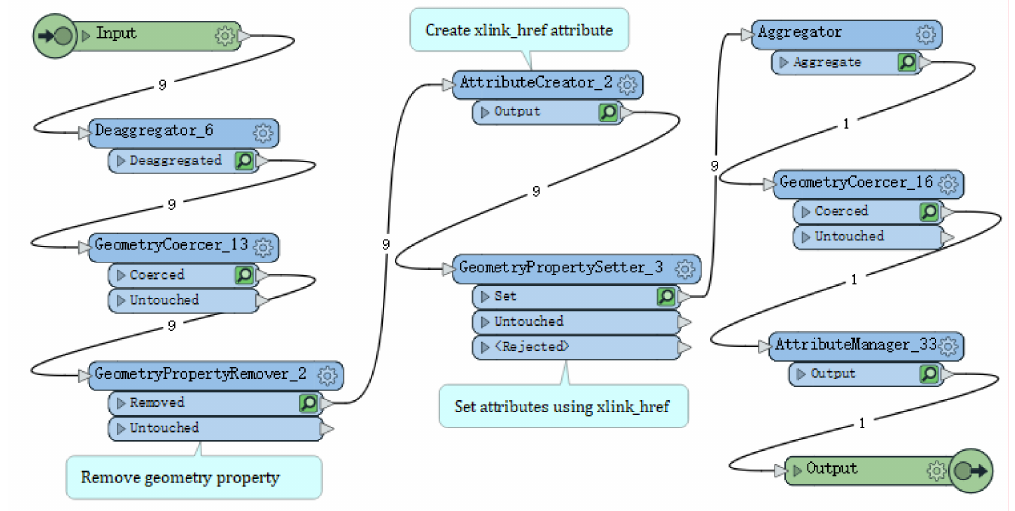
Figure 23. Customized transformer for construction of a